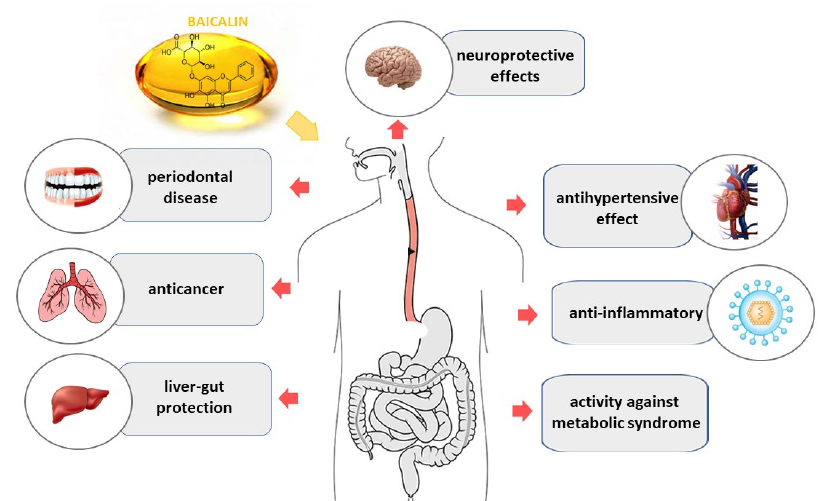
Figure 2. Selected pharmacological effects of baicalin ( 1 ) in humans.